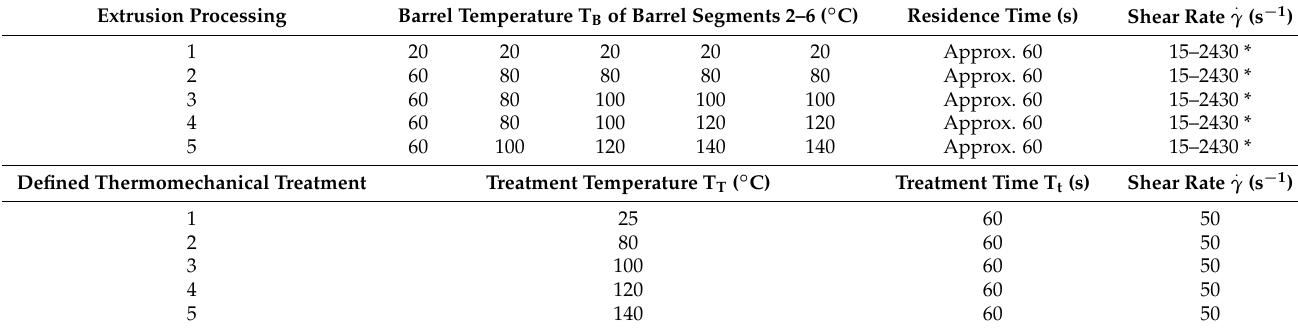
Table 1. Experimental set-up for extrusion-processing and treatments at defined thermomechanical conditions. Extrusion Processing